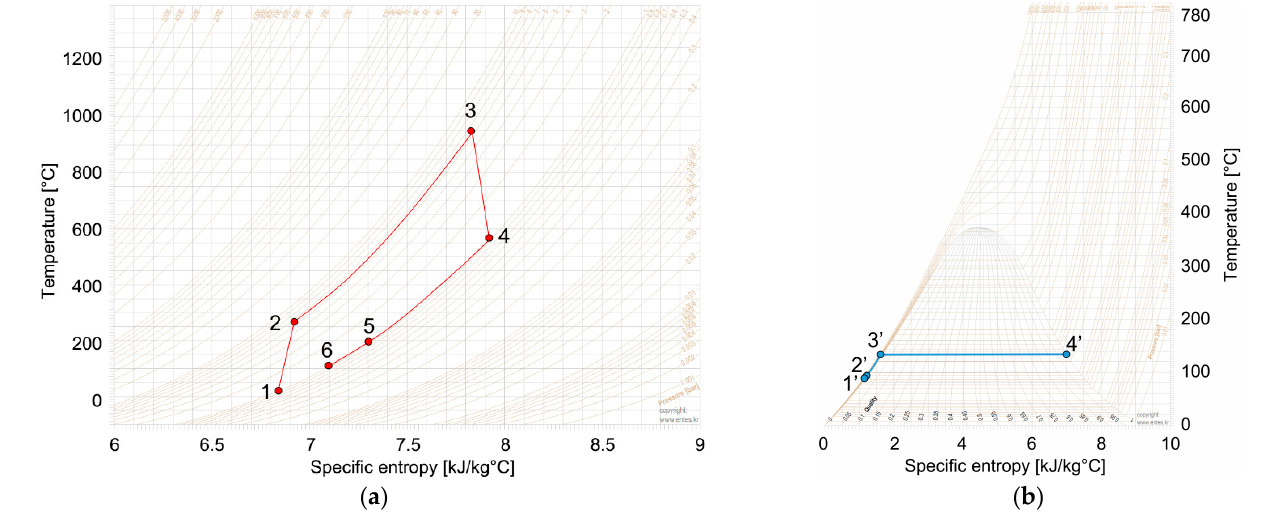
Figure 2. Thermodynamic representation of topping ( a ) and bottoming ( b ) cycle.